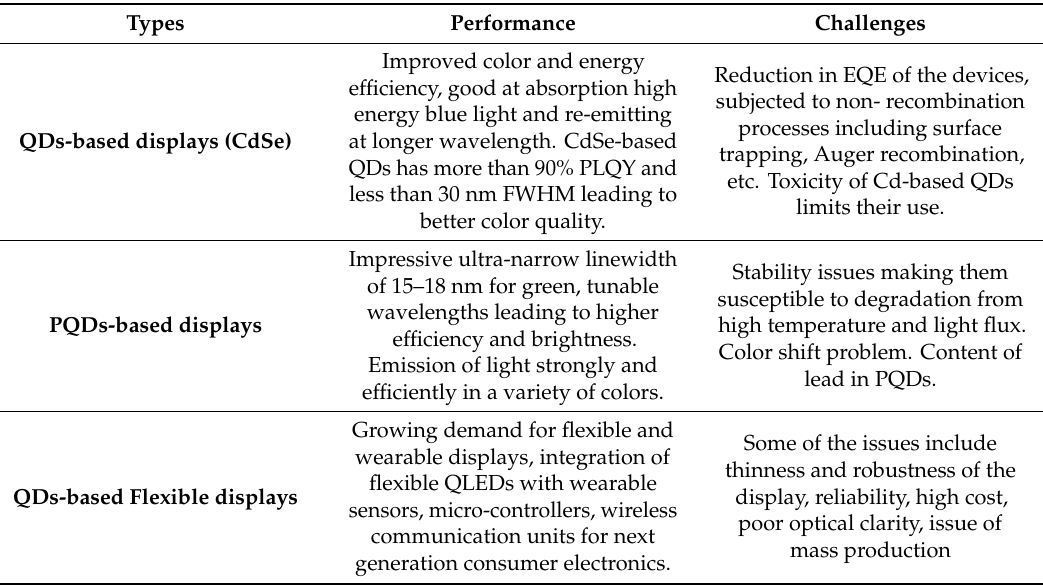
Table 2. Comparative study of di ff erent display